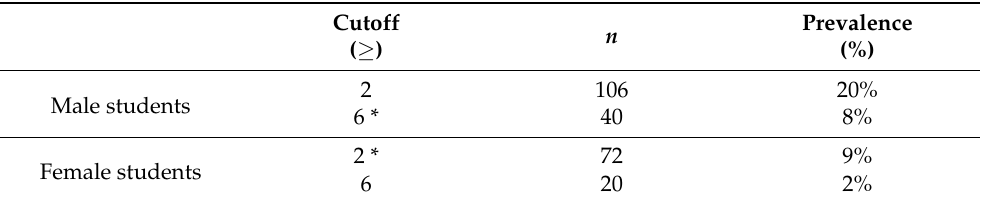
Table 4. Distribution of drug-related problems based on gender when applying the previous sug- gested cutoffs of 2 and 6 points on the DUDIT total scale. Cutoff Prevalence n ( ≥ ) (%)